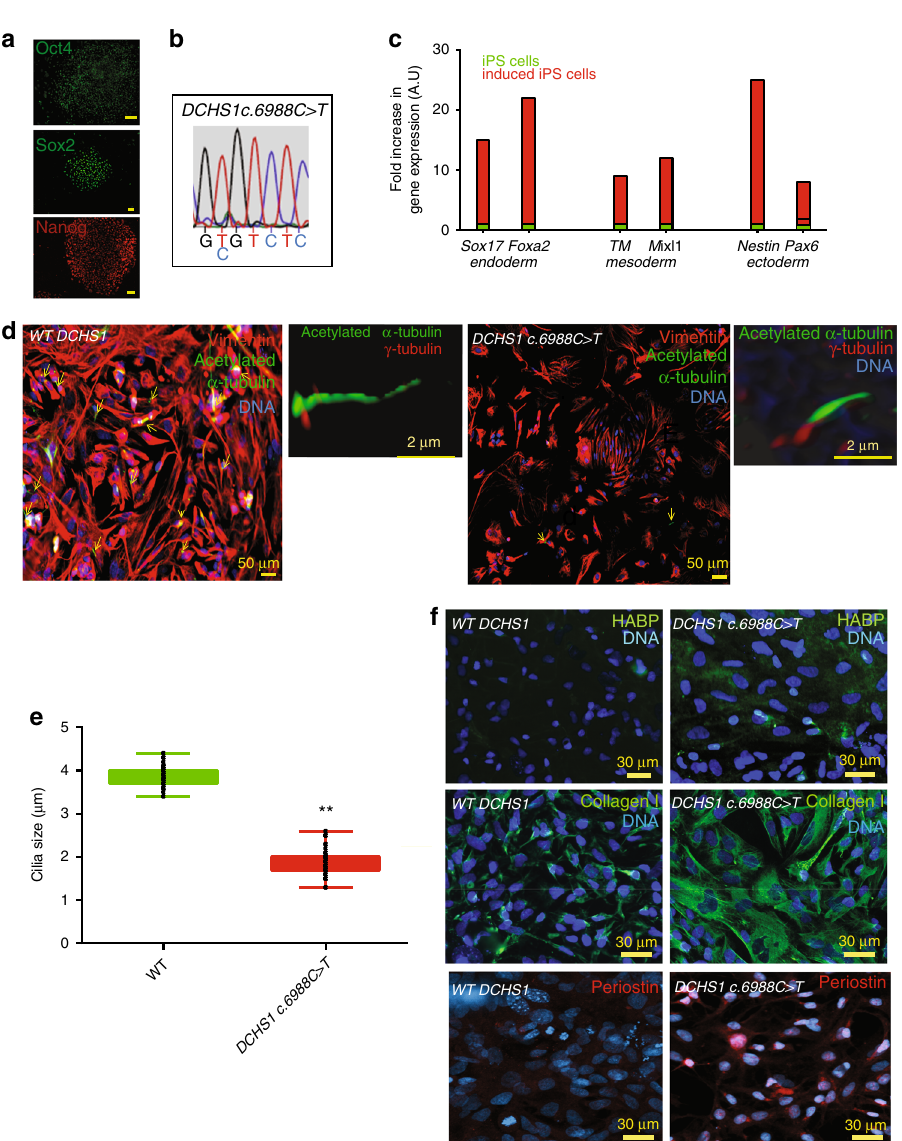
Fig. 5 DCHS1 c.6988 C>T iPs cells recapitulate the patient valvular phenotype. a iPS cells derived from mitral valvular interstitial cells express OCT4, SOX2 and NANOG. b The patient-speci fi c DCHS1 c.6988C > T mutation was conserved following iPS cell derivation. c DCHS1 c.6988 C > T carrying iPS cells were differentiated toward the endoderm, mesoderm and ectoderm. Real-time PCR of Sox17, Foxa2 (endoderm), Brachyury (T) and Mixl1 (mesoderm) and Pax6 and Nestin (ectoderm) con fi rmed multilineage propensity. d Wild type (WT DCHS1) or mutated (DCHS1 c.6988 C>T) HPVCs underwent EMT under BMP2 stimulation and were immunostained with anti-vimentin and α -acetylated tubulin to visualize cilia. Insets show 3D-image of cilia co-immunostained with both anti- α -acetylated tubulin and anti- γ -tubulin antibody. e Quanti fi cation of cilia size: Cilia were stained by anti- α -acetylated tubulin and anti- γ - tubulin. Length of the cilia was measured using Image J in 47 cells randomly chosen from 3 separate experiments. Boxes and whiskers (min to max) show the values lower than the 2.5th percentile and greater than the 97.5th percentile as circles. (**signi fi cantly different, p ≤ 0.01). f Hyaluronan, collagen I and periostin were visualized by anti-HABP antibody, anti-collagen I and anti-periostin antibodies, respectively in cultures of VIC derived from both wild type (WT DCHS1 ) or mutated ( DCHS1 c.6988 C>T ) HPVCs. To quantify HYALURONAN and collagenI, 3 fi elds in 3 separate experiments were scored using